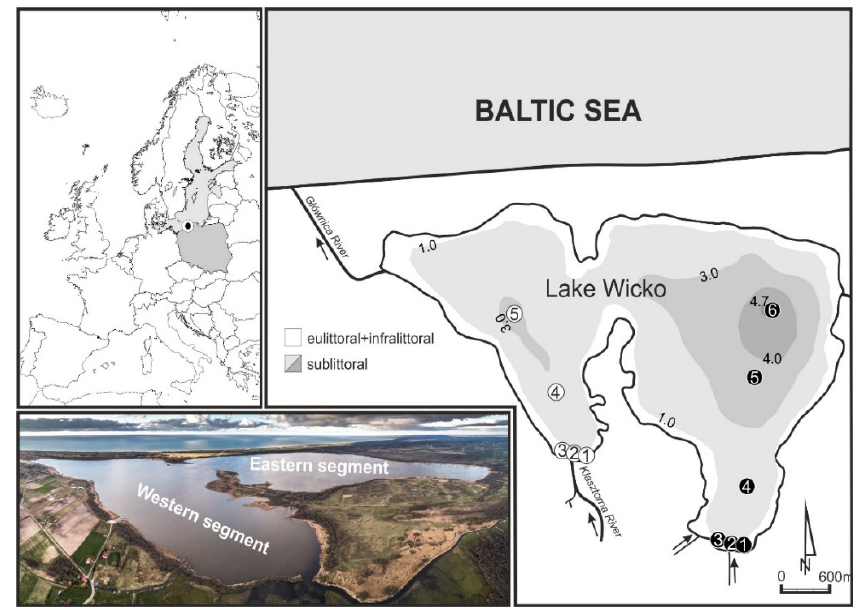
Figure 1. Location of sampling sites and morphometric cross-sections of Lake Wicko.